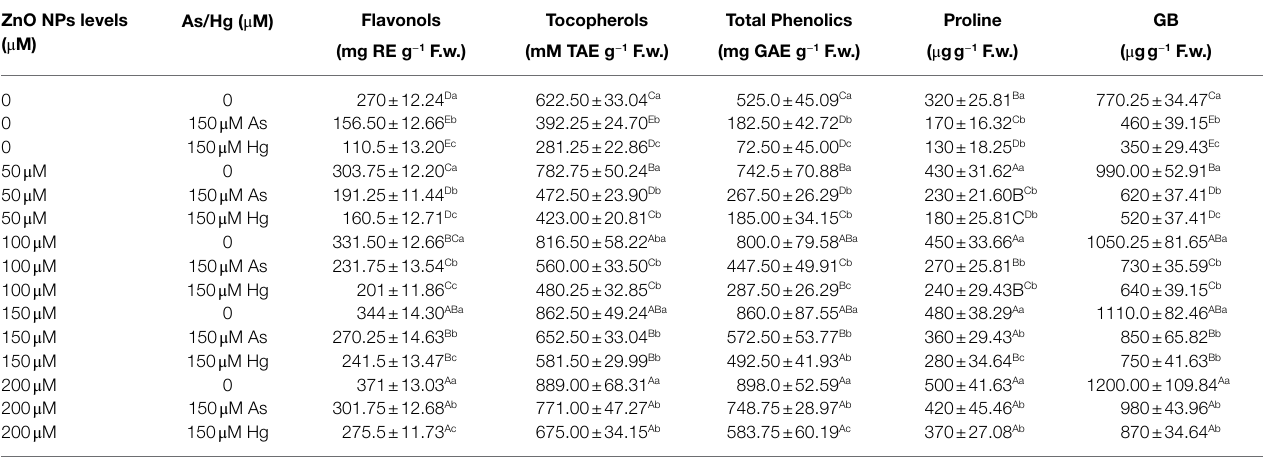
TABLE 1 | Impact of the combination of ZnO-NPs with 150 μ M As and 150 μ M Hg on the non-enzymatic antioxidants (total phenolics, flavonols, and tocopherols), proline content and glycine betaine (GB) content. ZnO NPs levels As/Hg ( μ M) Flavonols ( μ M) (mg RE g − 1 F.w.)